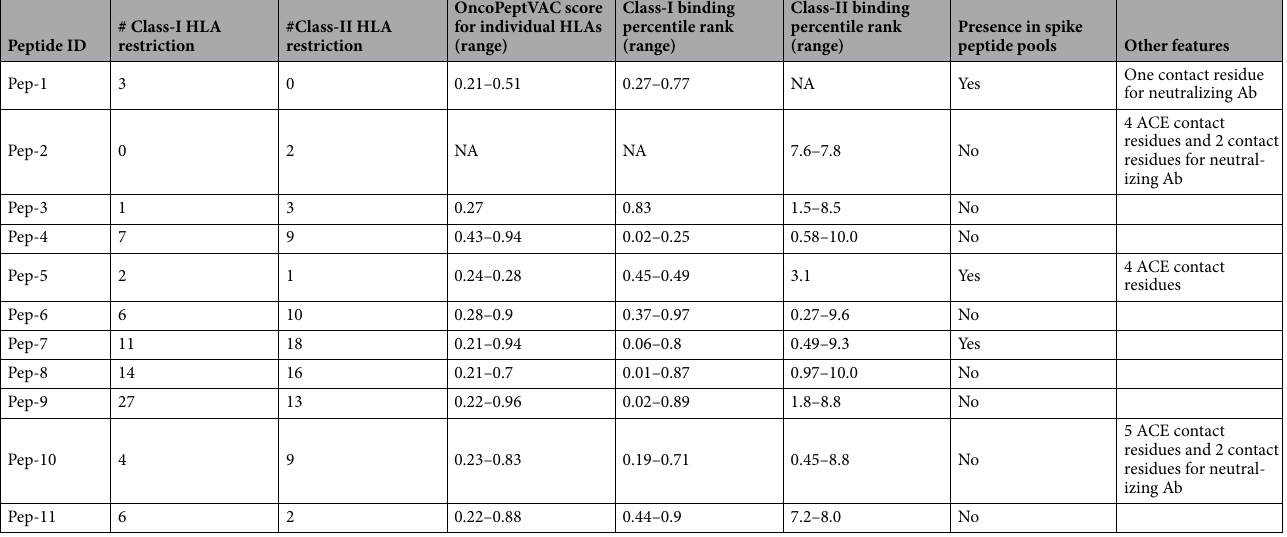
Table 1. Peptides selected by OncoPeptVAC for use in T-cell activation